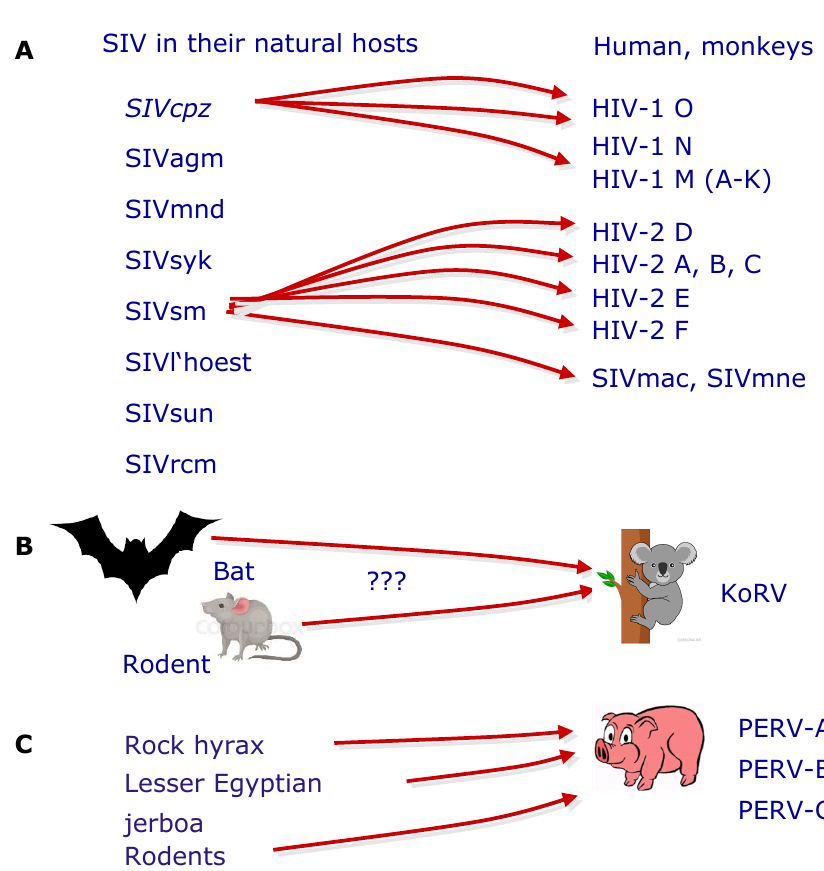
Figure 2. Examples of trans-species transmission of retroviruses. ( A ) Transmission of simian immunodeficiency viruses (SIV) from chimpanzee (cpz) or sooty mangabey (sm), which are apathogenic in their natural hosts, resulting in highly pathogenic human immunodeficiency viruses (HIV-1 and HIV-2). Different clades of HIV-1 and HIV-2 were described; all induce acquired immunodeficiency syndrome (AIDS). SIVsm also induces AIDS in rhesus monkeys (SIVmac) or Macaca nemestrina (SIVmne) [49 – 51]. ( B ) Example of a trans-species transmission of a gammaretrovirus, the koala retrovirus (KoRV), which is closely related to PERV, which induces lymphoma and immunodeficiency in koalas, and which was possibly derived from bats or rodents [52,53]. ( C ) Trans-species transmission from different species resulted in integrated PERVs in the pig genome [47,48].